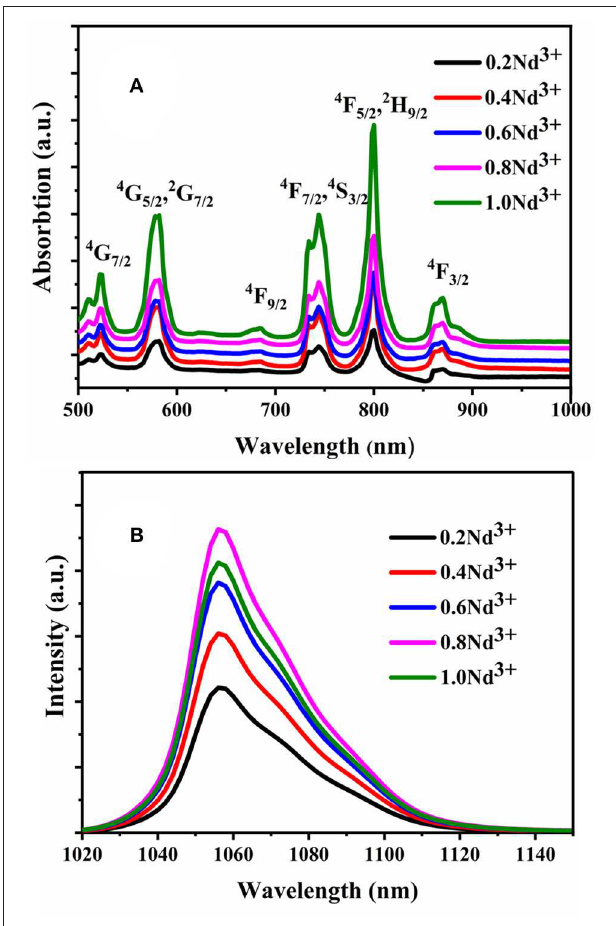
FIGURE 1 | (A) Absorption spectra of x mol% Nd 3 + doped fluorosilicate glass sample and (B) photoluminescence emission spectra of x mol% Nd 3 + doped fluorosilicate glass sample under the excitation of a λ ∼ 808nm laser. ( x = 0.2, 0.4, 0.6, 0.8, and 1.0).